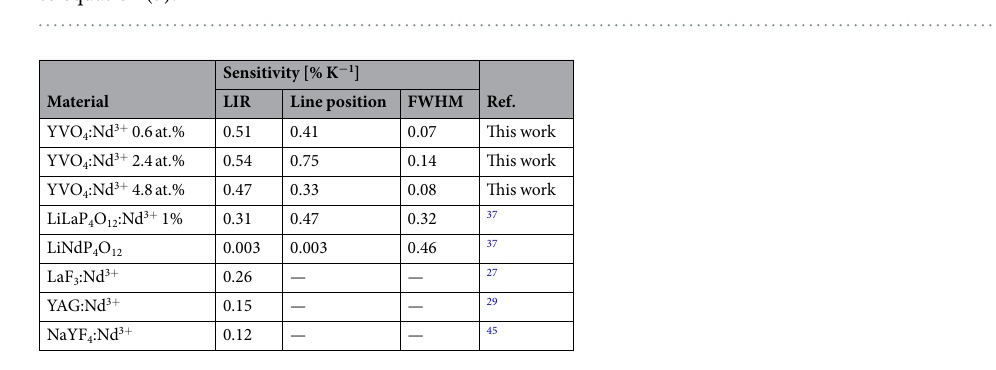
Figure 4. ( a ) Normalized emission spectra of 4 F 3/2 (R 1,2 ) − 4 I 9/2 (Z 5 ) transition obtained at different temperatures (123–873 K); ( b ) FWHM of 4 F 3/2 (R 1,2 ) − 4 I 9/2 (Z 5 ) transition as a function of temperature with fit to equation (3).